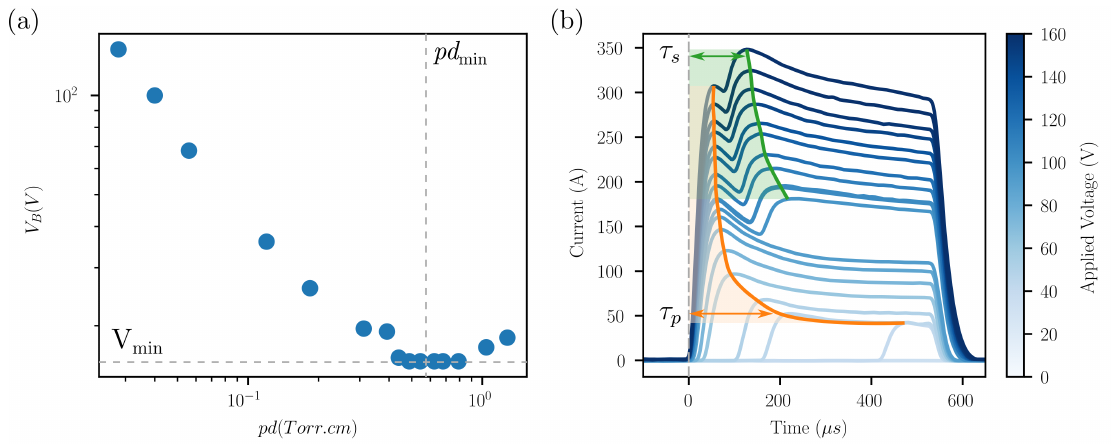
Figure 2. Plasma discharge measurements with external heating at 5 kW and solenoid current of 10 A. ( a ) Curve of plasma breakdown voltages V B where I > 1 A. Minimum breakdown voltage is 15.6 V at a pressure of p = 7.8 × 10 − 2 Torr ( d = 8 cm). ( b ) Current traces of discharges at different applied voltages. Voltage pulse is applied 0 < t < 600 µ s and τ p , τ s are the primary and secondary formative time lags for reaching steady state